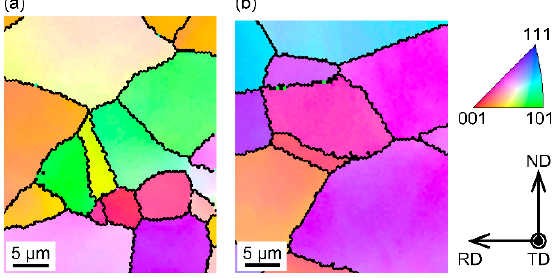
Figure 11. IPF maps of the rolled specimens after heat treatment at 600 °C for ( a ) 1 min and for ( b ) 5 min.